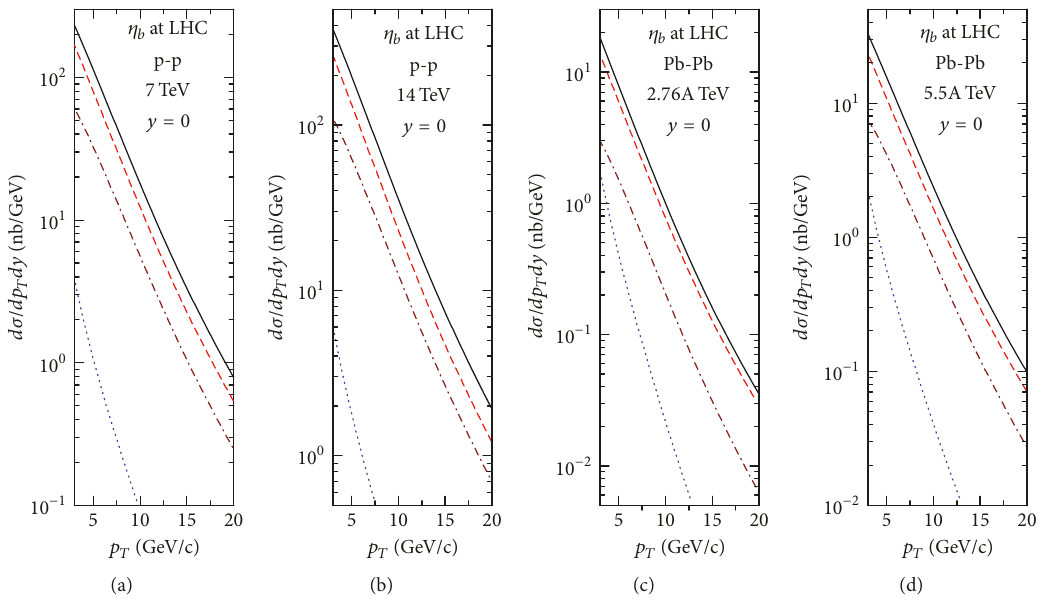
Figure 2: The same as Figure 1 but for large- 𝑝 𝑇 𝜂 𝑏 meson production from gluon-gluon interaction at midrapidity in p-p and Pb-Pb collisions at the